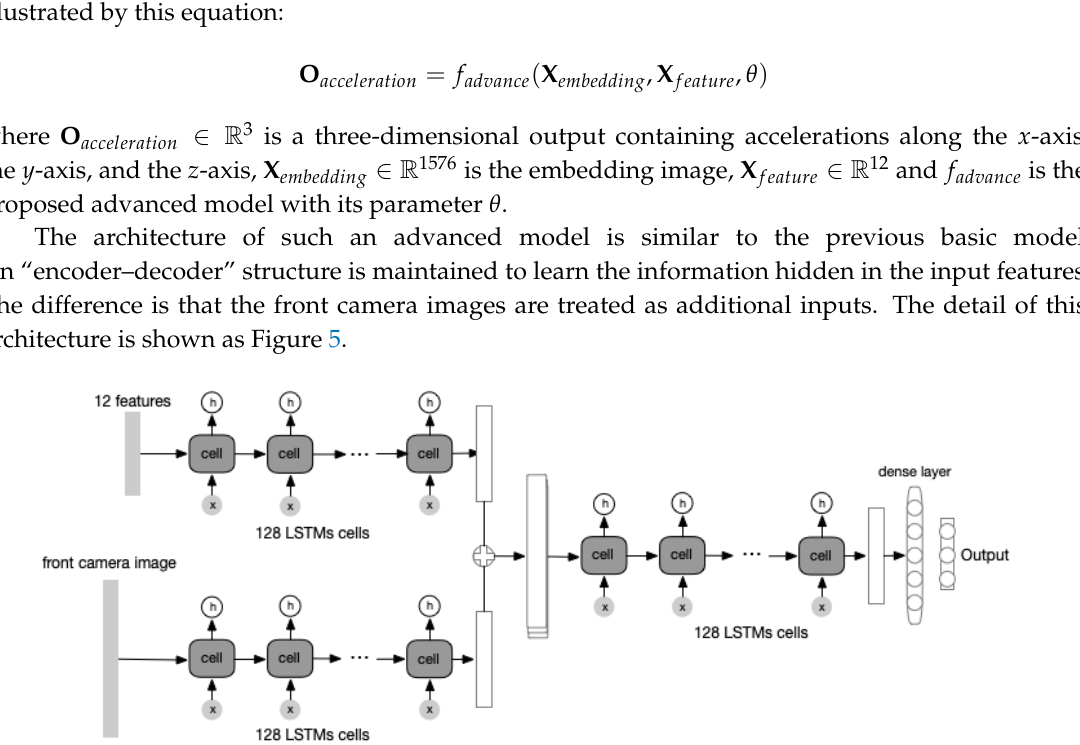
Figure 5. Notice that the “image” input is a vector containing key image contents. The first channel input is the 12 features for the observed 10 frames. The second channel input is the 1576-dimensional representation of front camera images from these 10 frames. Such representation is extracted from the second last output of a pre-trained Resnet152v2. The outputs from both channels are concatenated to form a representation with information from the features and image contents. The representation is stacked and fed in the same way as the basic model. The output is the acceleration for the future five frames. The “encoder” module contains 128 LSTM-cells and the “decoder” module contains 128 LSTM-cells. The optimizer of this network is RMSprop with learning rate 0.0001 and the dropout is used for each LSTM-cell with probability